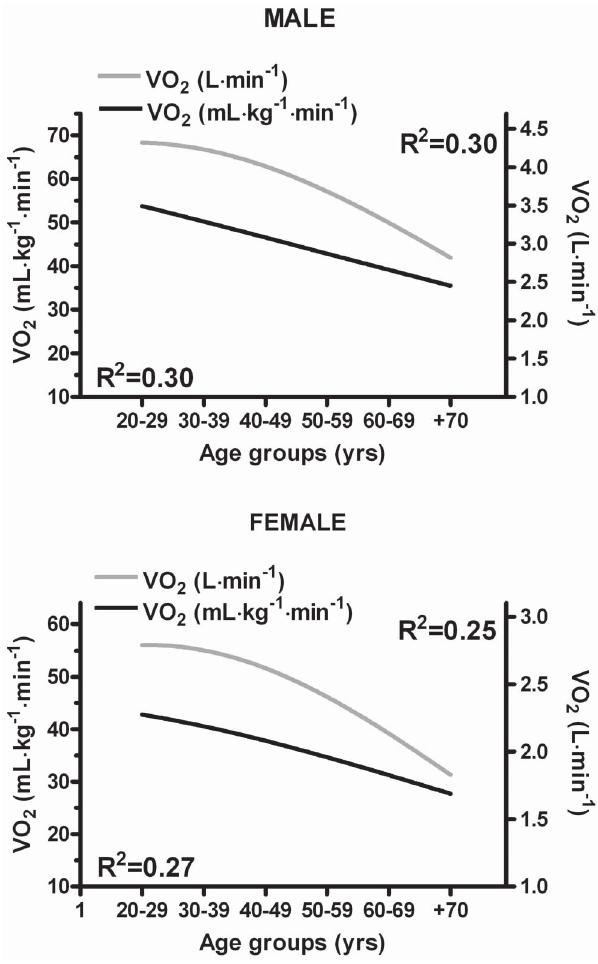
Figure 4. Decline of oxygen uptake (VO 2 ) relative to age. Mean and SD for each age group is presented in Table